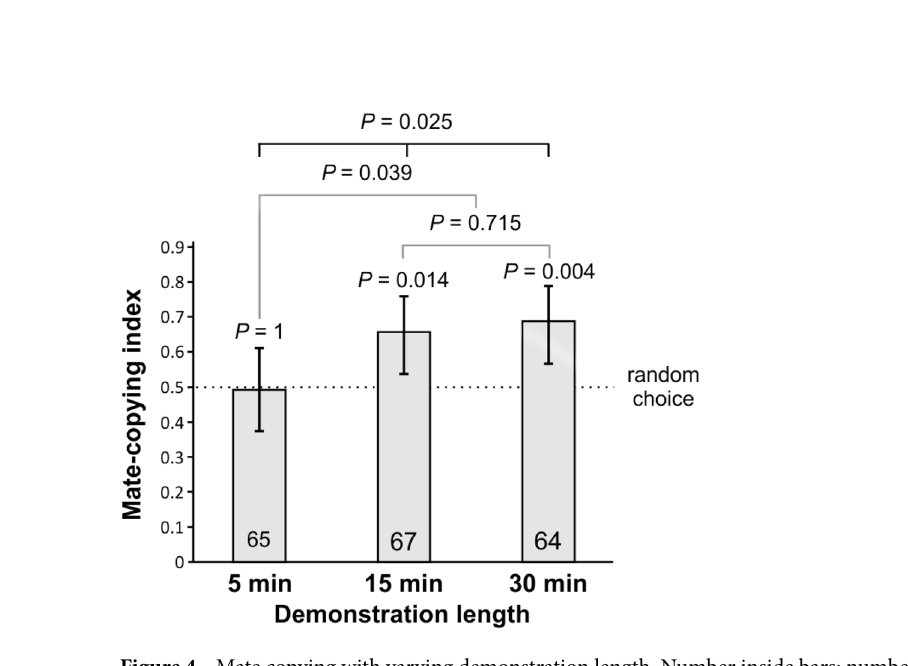
Figure 4. Mate copying with varying demonstration length. Number inside bars: number of trials. Statistics above each bar are the P-values of the binomial tests of departure from random choice (represented by the dashed line), and the one above the horizontal black bar is that of a GLMM comparing the effect of treatment in the three groups. The grey horizontal bars provide the P values of a Fisher test to compare the 15 min and 30 min treatments and these two with the 5 min treatment. We used Holms correction for multiple testing. Error bars represent Agresti-Coull 95% confidence